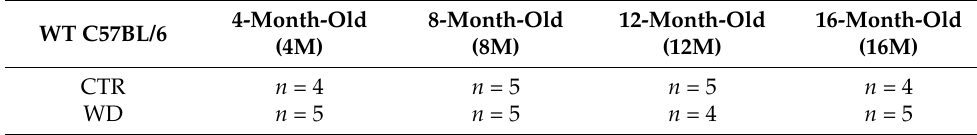
Table 1. Number of animals per group in wild-type C57BL/6J mice.